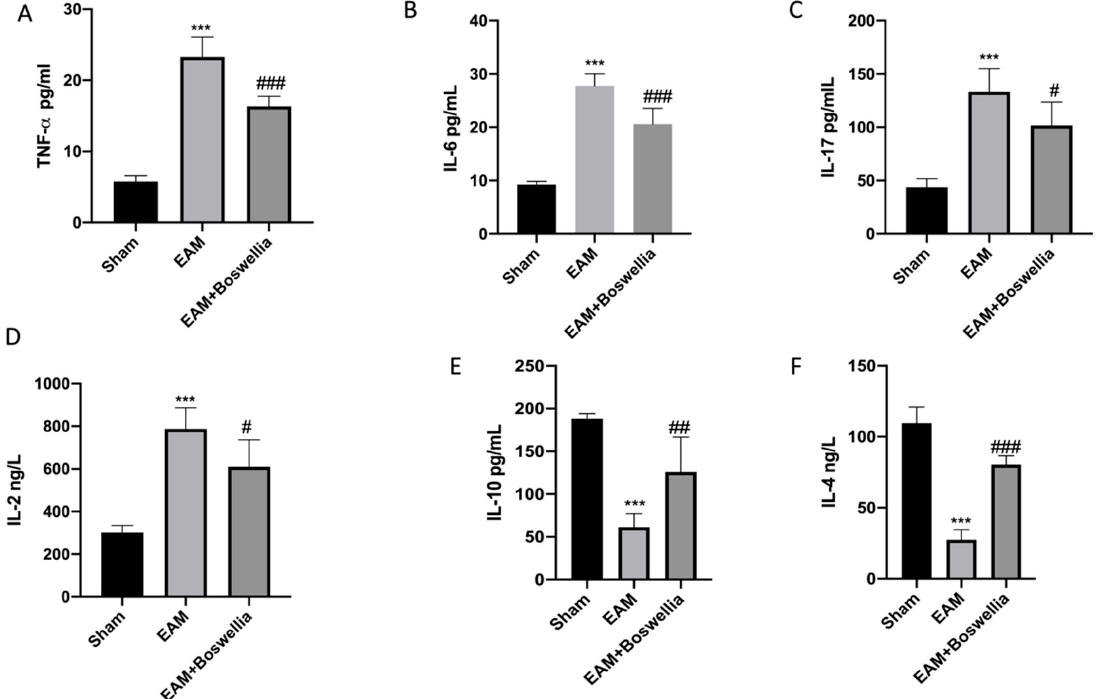
Figure 5. Effect of Boswellia extract on cytokines levels. Serum levels of TNF- α ( A ), IL-6 ( B ), IL-17 ( C ), IL-2 ( D ), IL-10 ( E ), IL-4 ( F ). Boswellia extract administration was able to reduce proinflammatory cytokines and increase anti-inflammatory cytokines. Values = means ± SEM of 6 animals for each set. *** p < 0.001 vs. sham; ## p < 0.01 vs. EAM. ### p < 0.001 vs.EAM. # p < 0.05 vs.